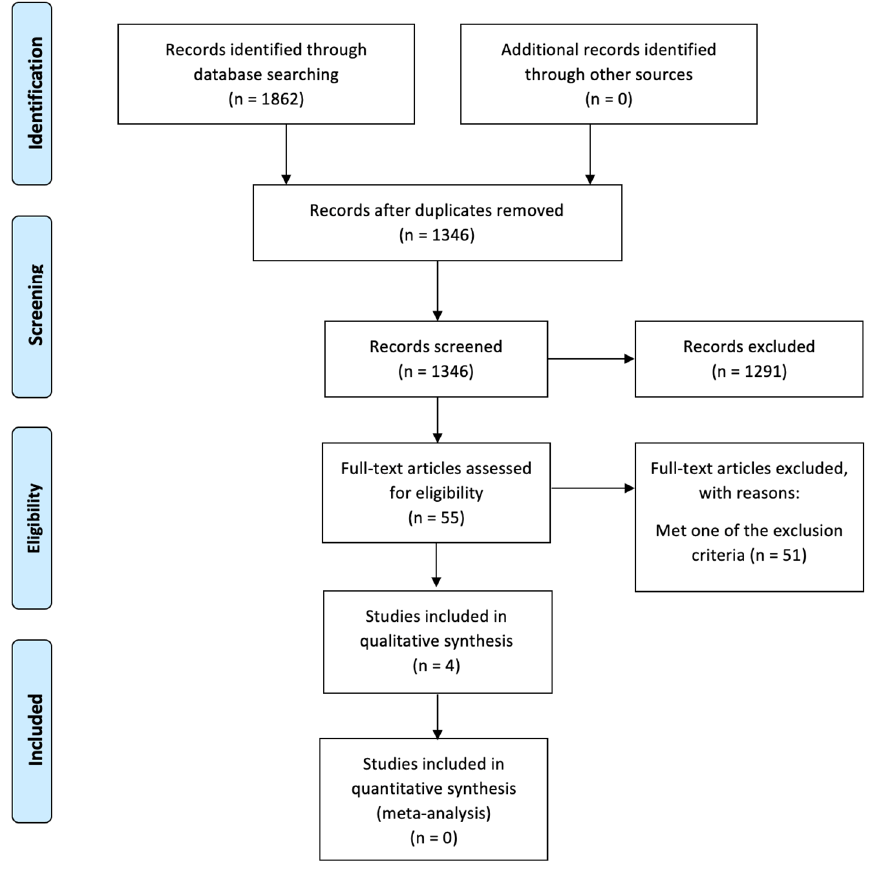
Figure 1. PRISMA flow diagram. Legend: The PRISMA diagram details the search and selection process applied during the systematic review.